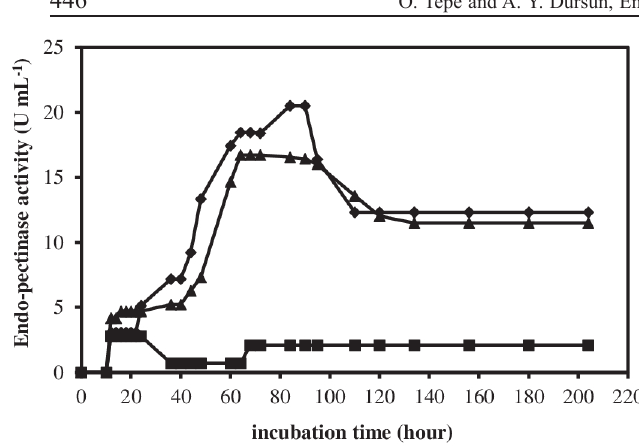
Fig. 7 – Effect of different K on endo-pectinase production by Bacillus pumilus NRRL B-212 (pH= 8, T: 30 °C, agitation rate: 150 rpm, Cpectin: 1 % (w/v), K HPO -KH PO concentrations; ■: 0.1-0.1 %, ♦: 0.3–0.15 %, 2 4 2 4 ▲ : 0.6-0.2 %